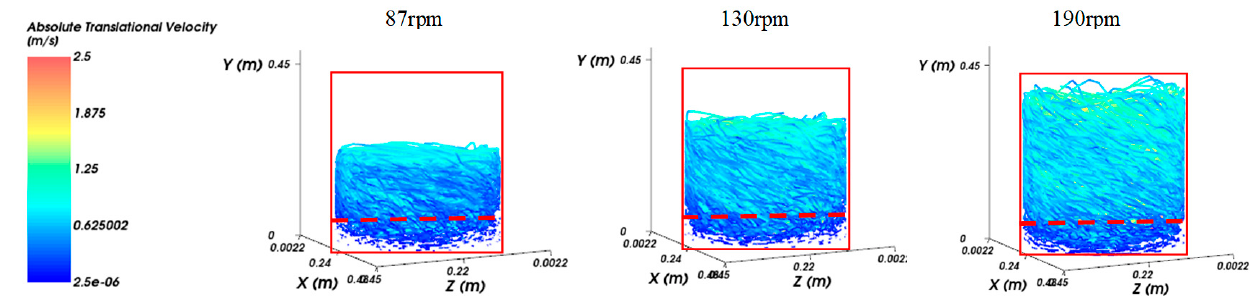
Figure 11. Particle trajectory at different mill rotational velocities.